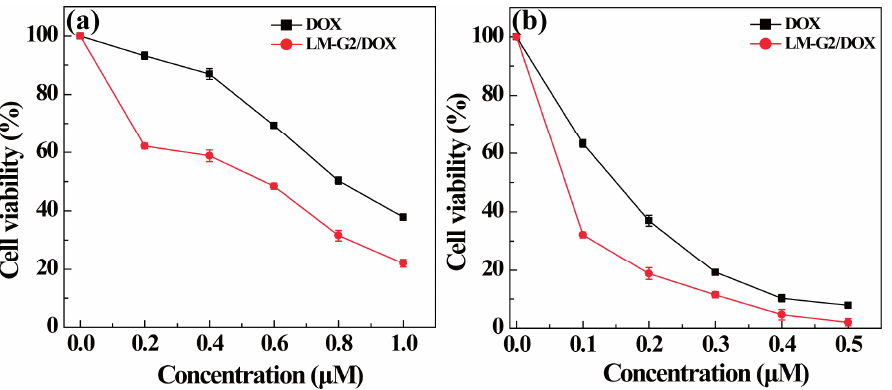
Figure 7. In vitro MTT cell viability assay of KB cells treated with LM-G2/DOX and free DOX at different DOX concentrations for ( a ) 24 h and ( b ) 48 h.